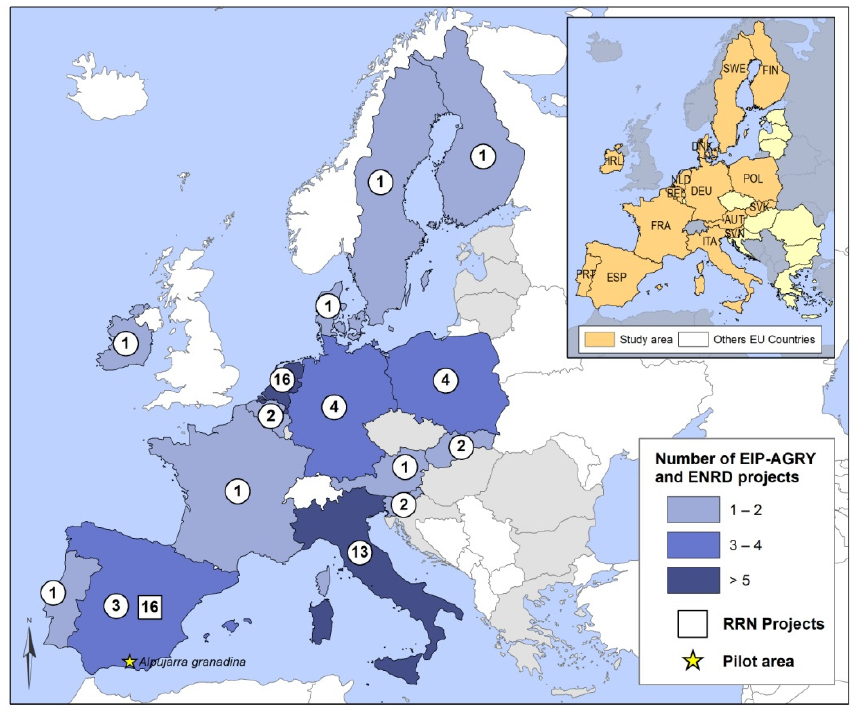
Figure 2. Location of the rural development projects analyzed in our review.